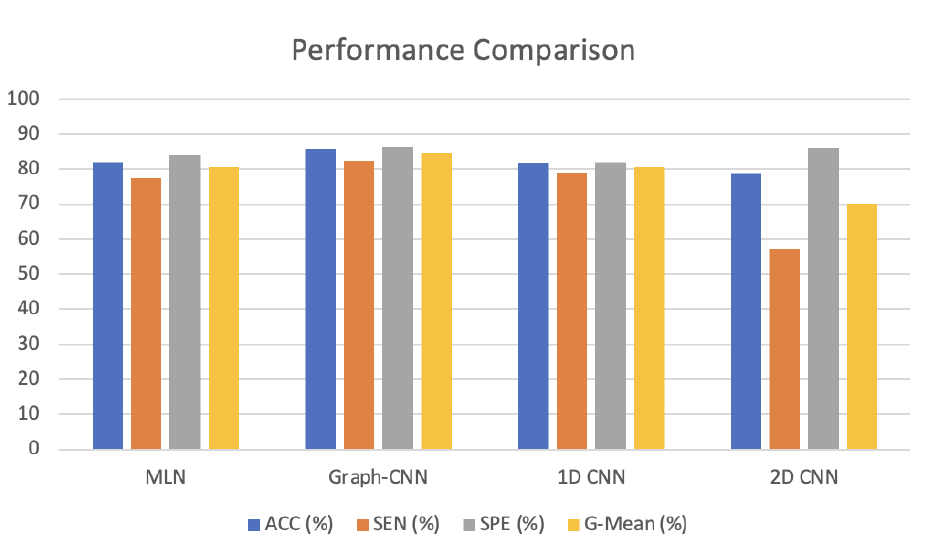
Figure 15. Performance comparison for different deep learning models.